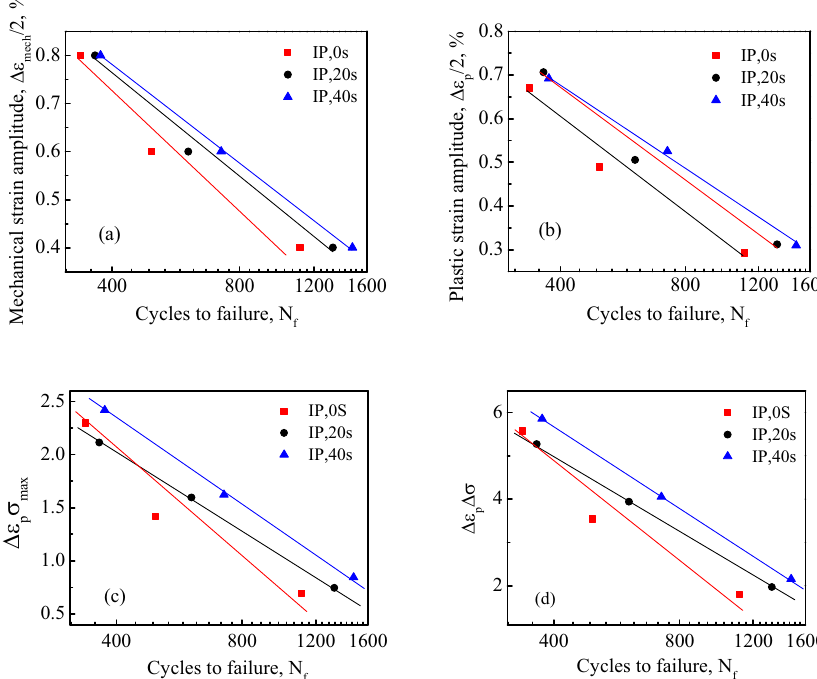
Figure 4: Relation between fatigue life and ( a ) mechanical strain amplitude, ( b ) plastic strain amplitude, ( c ) net tensile hysteresis energy, and ( d ) total deformation energy with di ff erent hold